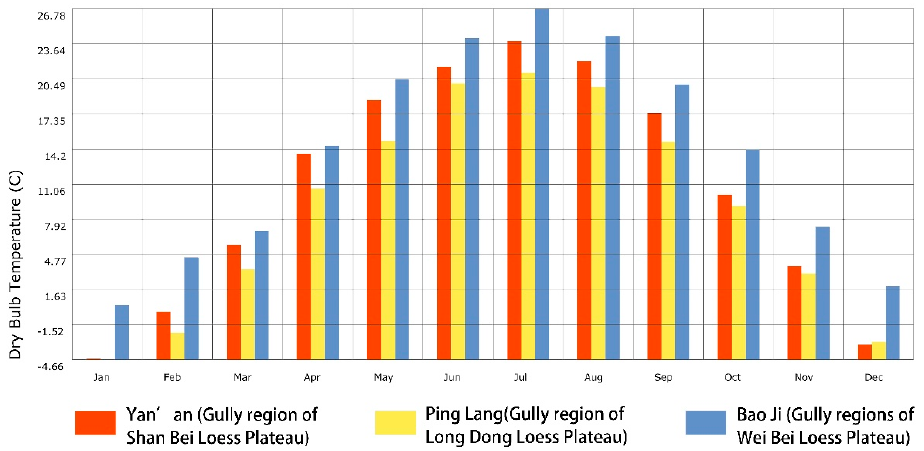
Figure 2. Mean monthly temperature of the typical cities in each gully region ( https://energyplus.net/weather-region/asia_wmo_region_2.)